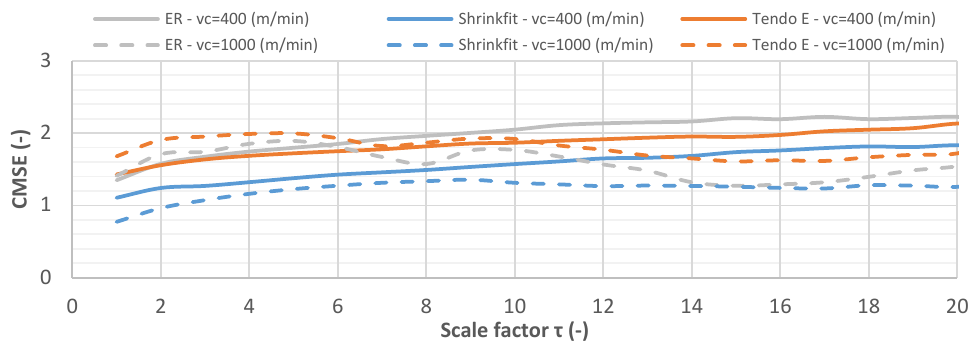
Figure 18. CMSE for vibration displacement signals while milling at v c = 400 m/min and v c = 1000 m/min (f z = 0.15 mm/tooth, a p = 6 mm).